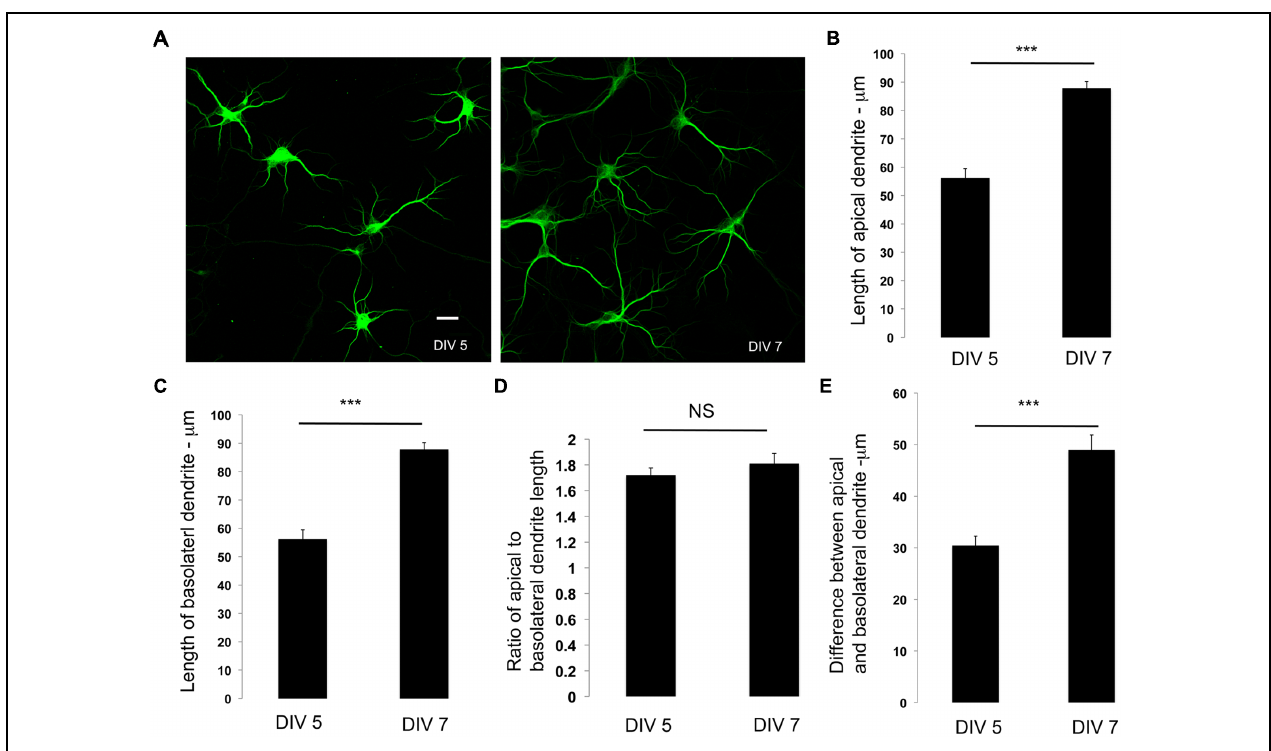
FIGURE 2 | Dendrite polarity is maintained during development. (A) Representative images of primary neurons in culture immunostained with antibodies to MAP2 at days in vitro indicated. (B) Lengths of apical dendrites at DIV 5 and 7. (C) Length of basolateral dendrites at DIV 5